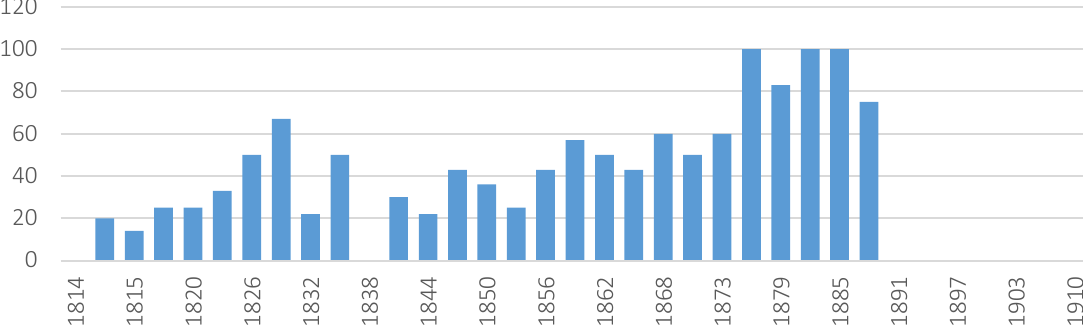
Figure 4. Occupational group “Non-farmer” in % of all Haugean representatives,